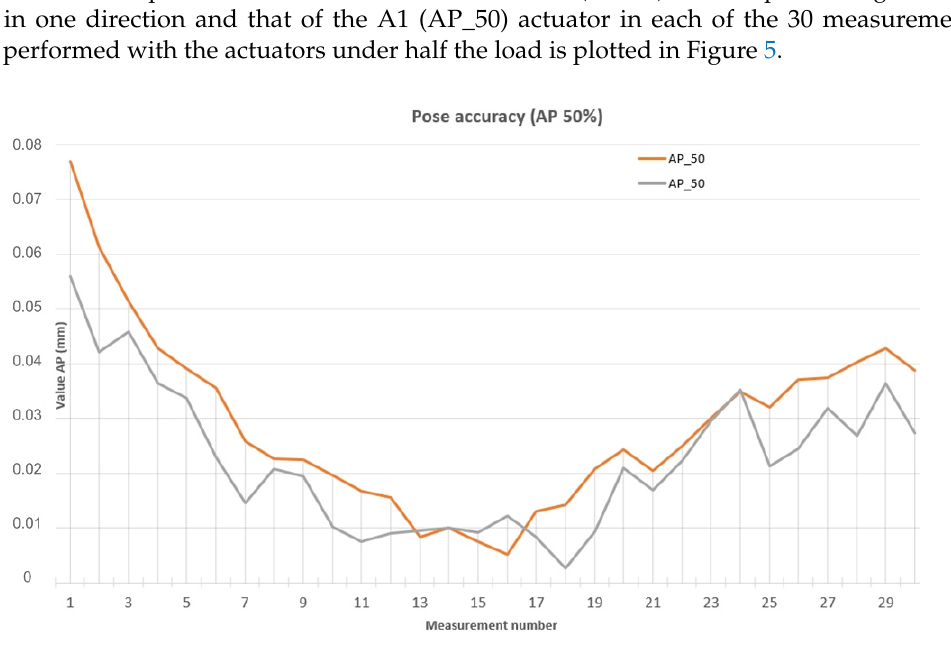
Table 4. Calculated AP 100 values of actuators under full load.